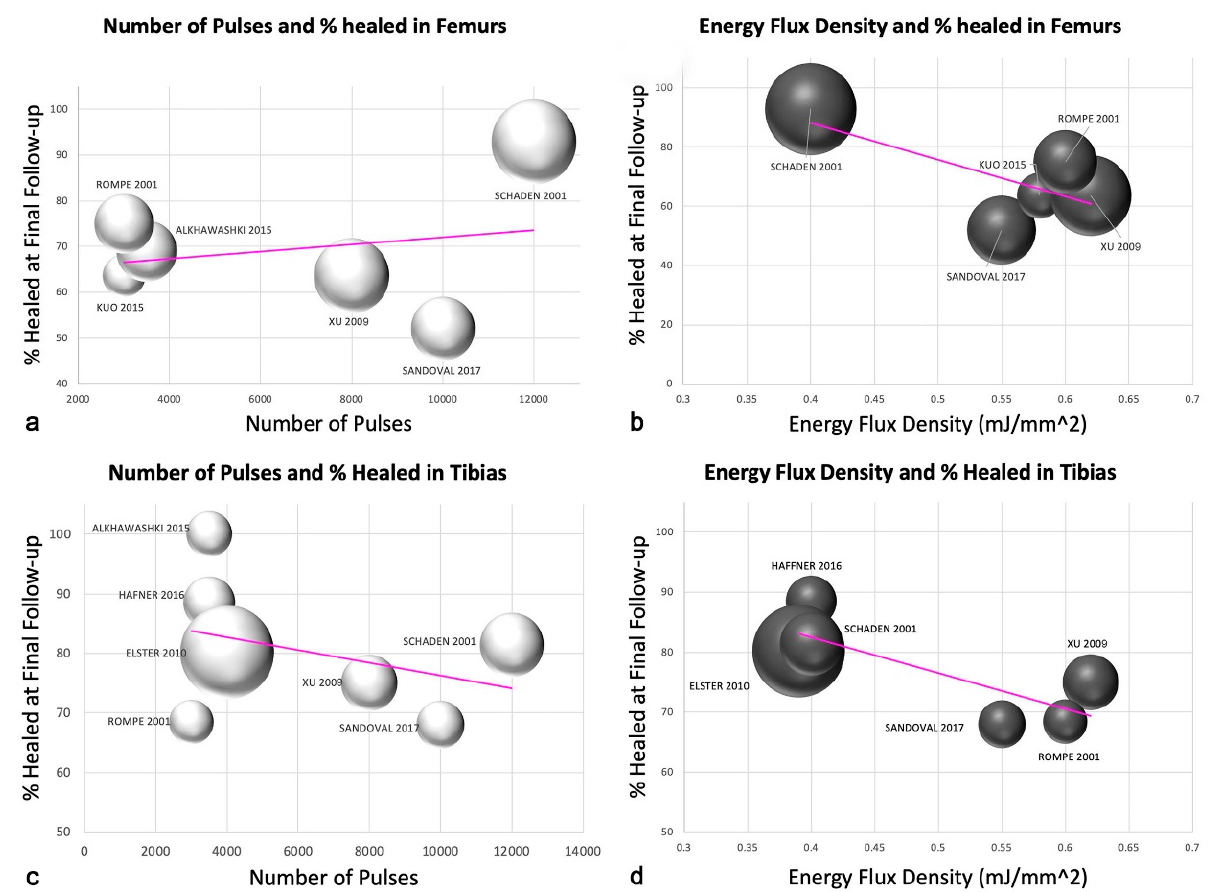
Figure 3. Scatter plots for the number of pulses and healing rates for femurs ( a ) and tibiae ( c ). Scatter plots for the energy flux density and healing rates in femurs ( b ) and tibiae ( d ). For Figures ( a – d ), the size of each plotted data point represents the number of patients in the study [25,26,29,38,39,43,44,50].